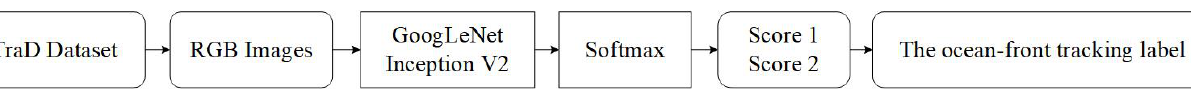
Figure 3. The procedure of the proposed ocean-front tracking algorithm. The input RGB images are fed to a GoogLeNet Inception network. Then, the softmax gives the probabilities of the input image belonging to the foreground or the background. The foreground images are used to track the ocean-front location in a video sequence.